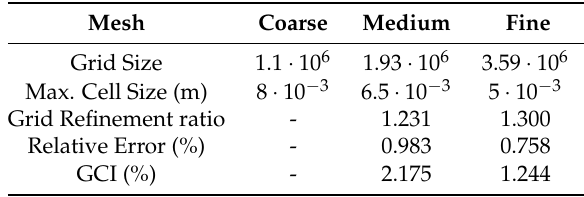
Table 3. Grid details and grid